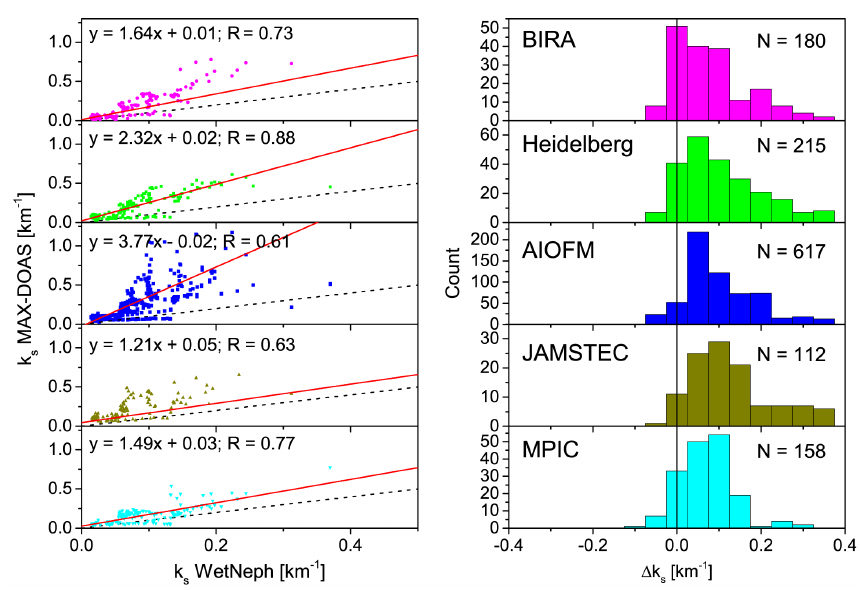
Figure 12. Left panels: correlation between surface extinction from the different groups and from WetNeph. The red line shows the linear fit and the dashed line the 1 : 1 line. Right panels: histograms of the difference in surface extinction (MAX-DOAS –